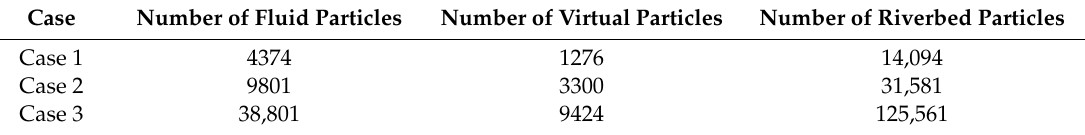
Table 3. Particle numbers for each case tested (unit: pcs).